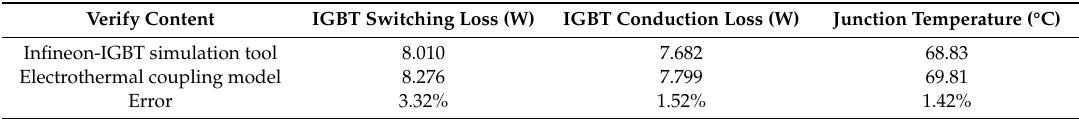
Table 1. Electrothermal coupling model